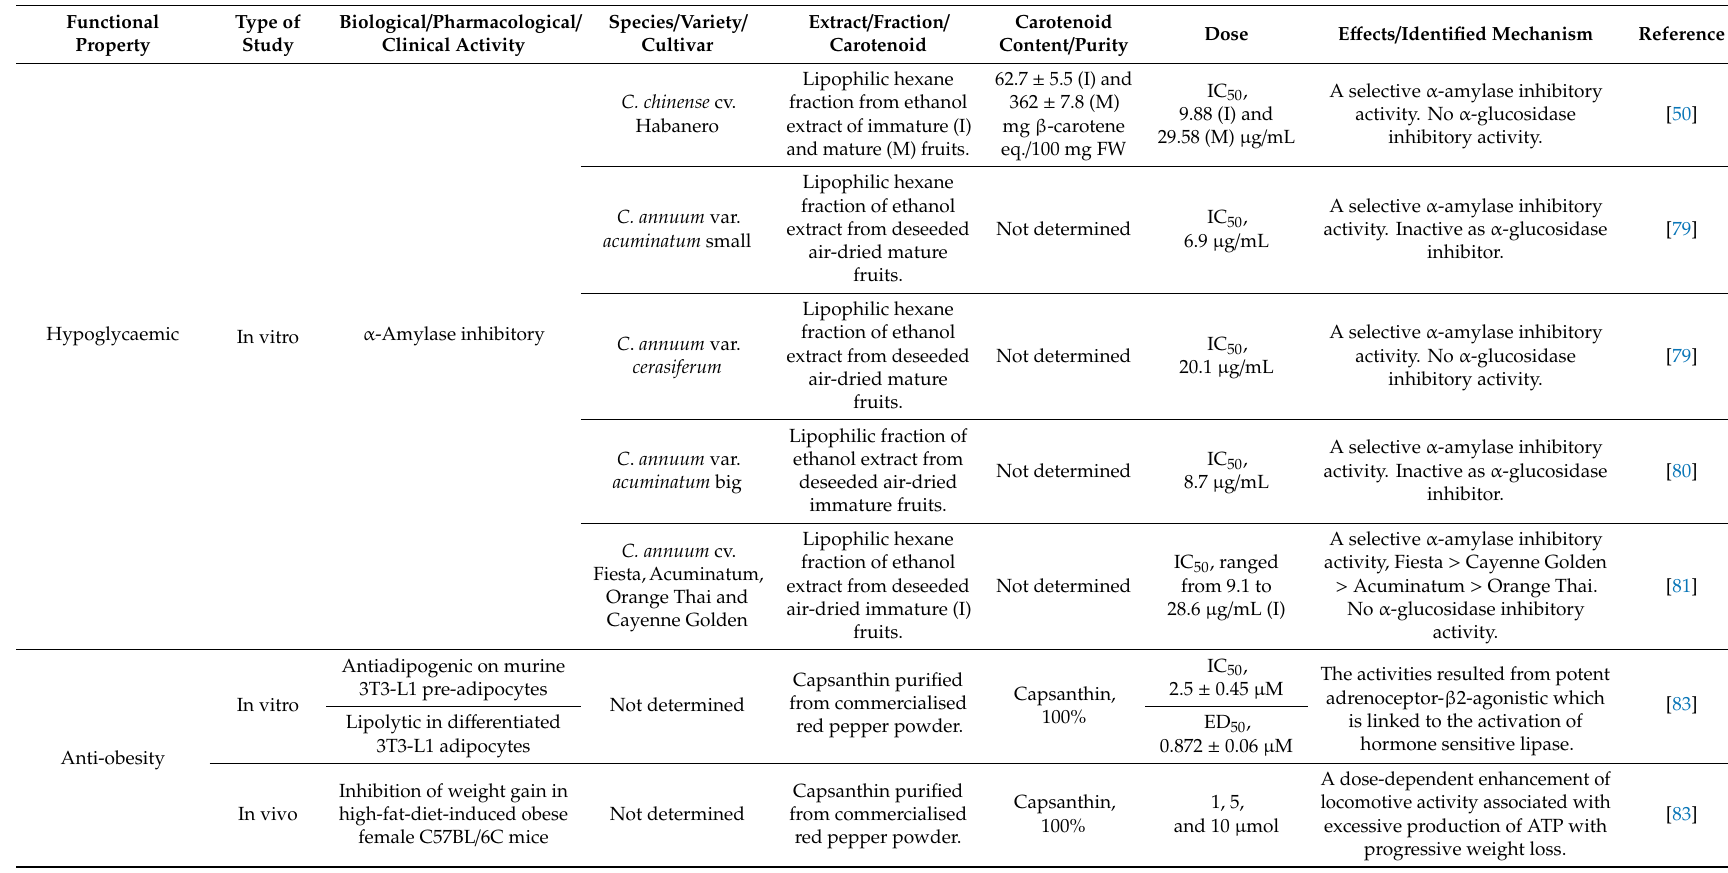
Table 2. Summary of in vitro, in vivo and clinical data from studies related to health-promoting functional properties of extract, fractions and carotenoids from Capsicum